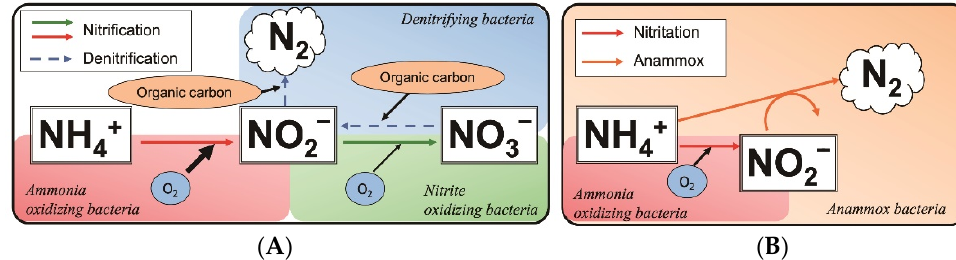
Figure 1. The conventional nitrogen removal process in RAS, with nitrification and denitrification compartments ( A ); the nitritation (partial nitrification)/anammox process ( B ).